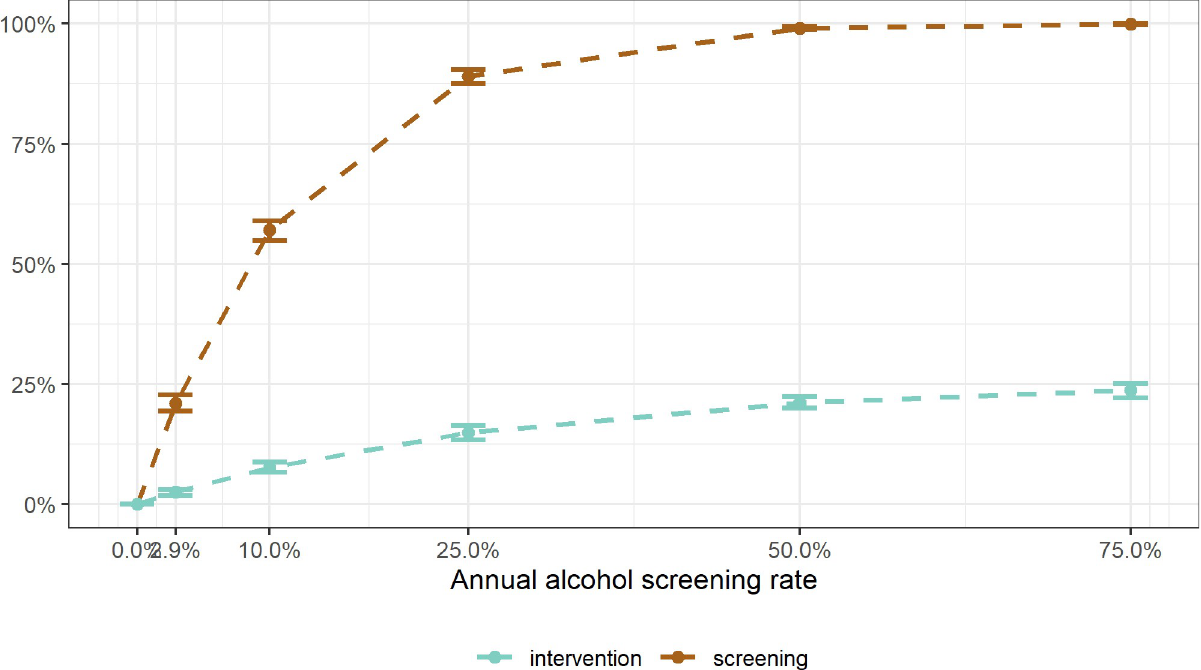
Fig 3. Alcohol screening and intervention rates at the end of the ten-year simulation period, depending on annual alcohol screening rate in German primary health care settings. The brown line is the percentage of the German population who was screened for their alcohol use. The green line is the percentage who received either a brief intervention (for medium-risk drinking) or were referred to treatment (for high-risk drinking).